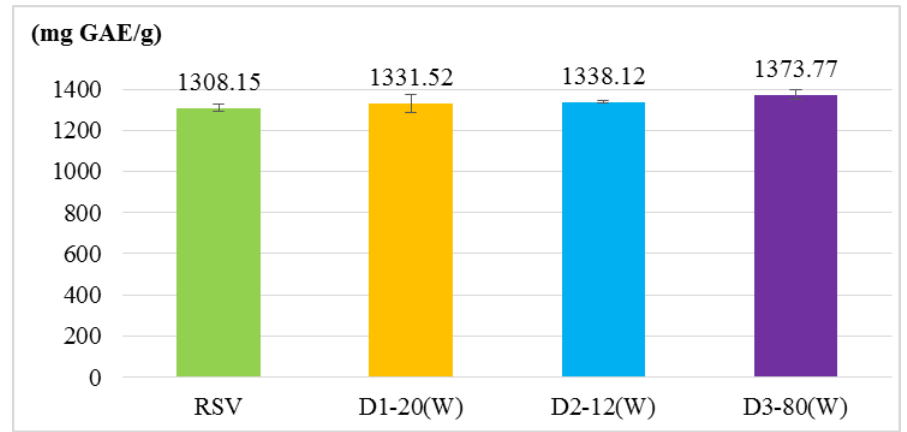
Figure 3. Total phenolic content of RSV and RSV transfersomes (D1–20(W), D2–12(W), and D3–80(W) groups). Total flavonoid content was measured by the Folin–Ciocalteu method and the results are presented as gallic acid equivalent (GAE). The 40 μL of sample was reacted with 40 μL of 2 N Folin-Ciocalteu reagent in a total volume of 600 μL. The values are means ± SD.